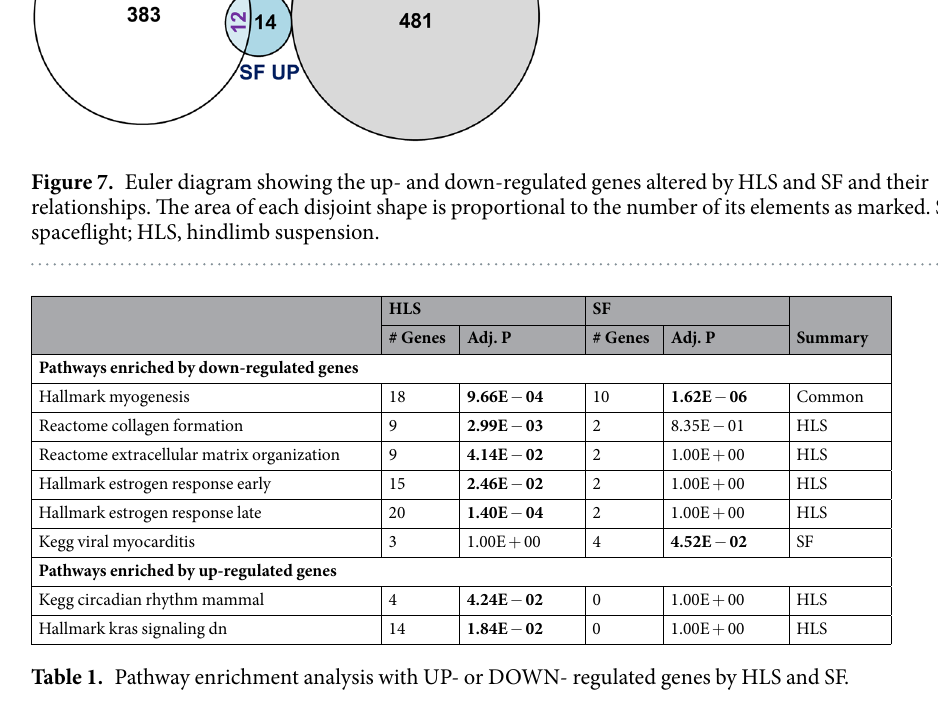
Table 1. Pathway enrichment analysis with UP- or DOWN- regulated genes by HLS and